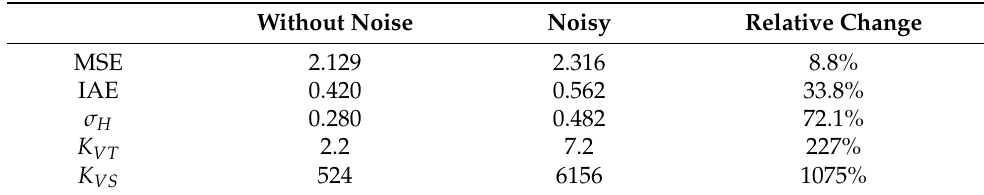
Table 6. G 3 ( s ) CPA